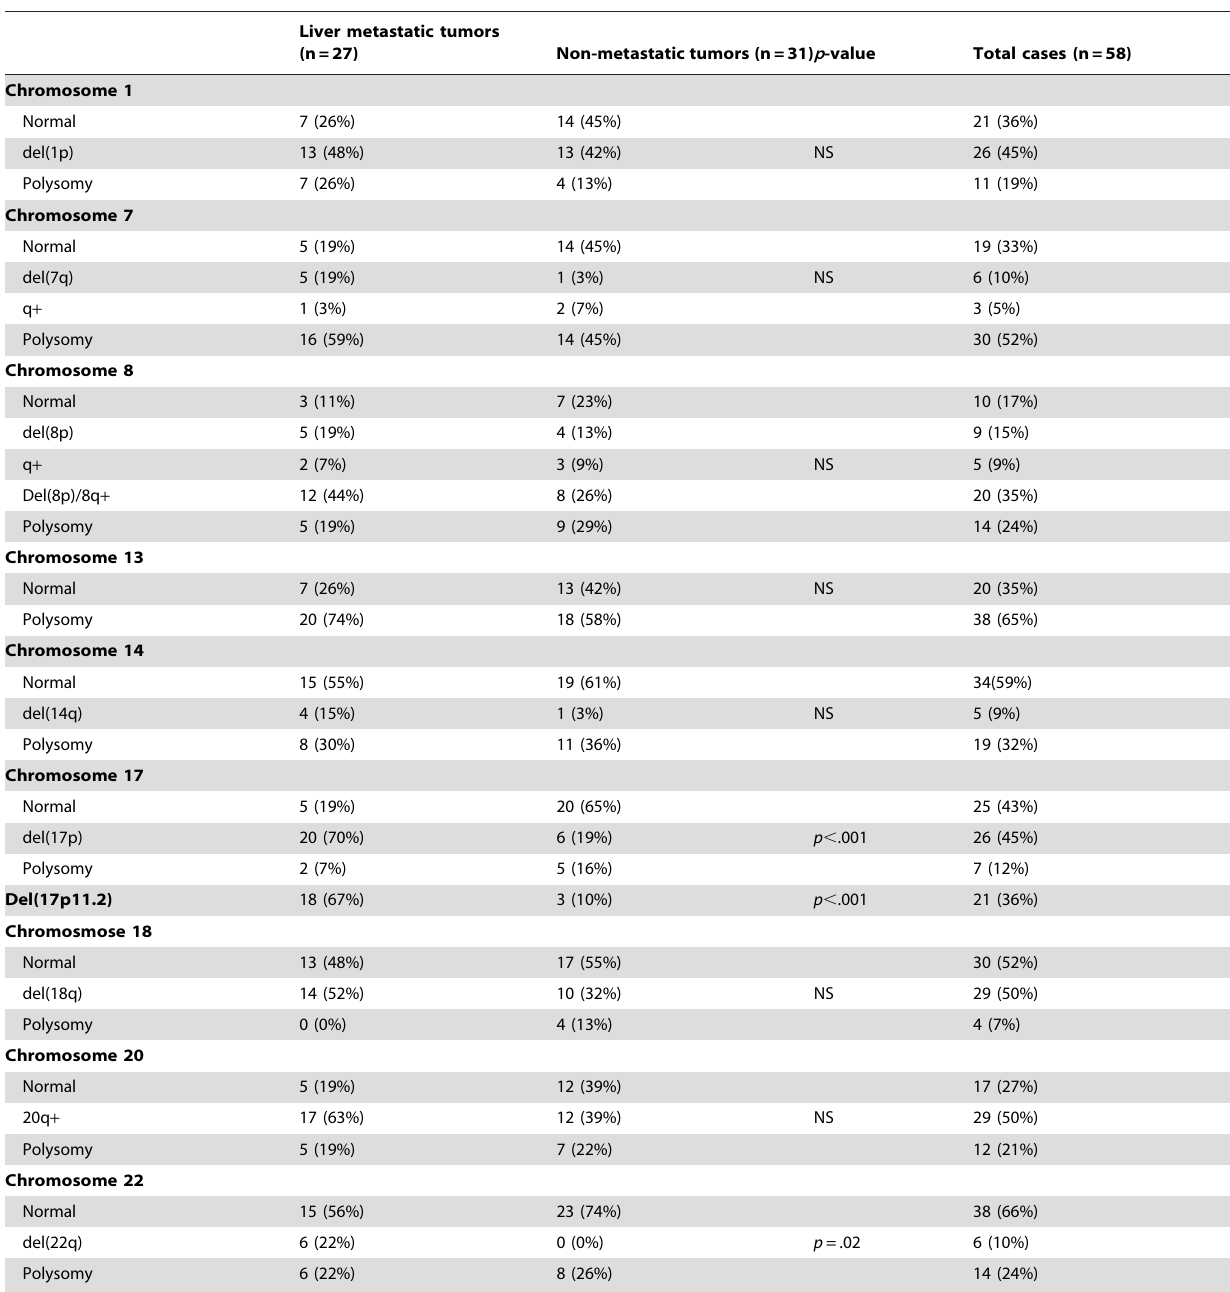
Table 2. Chromosomal alterations of primary tumors from liver metastatic (n=27) versus non-metastatic sCRC patients (n =31).